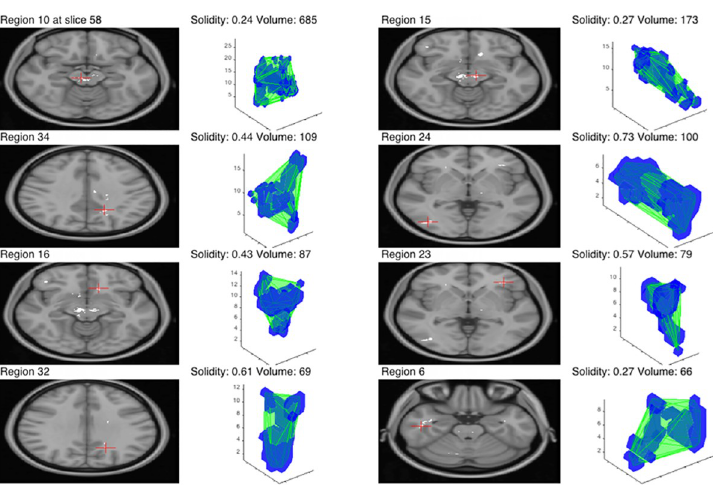
Fig 6. Eight biggest clusters for the joint metric. The green outline in 3D visualisation represents the convex hull of the cluster and the corresponding central slice is shown on the left with a red cross indicating the centre of the mass.